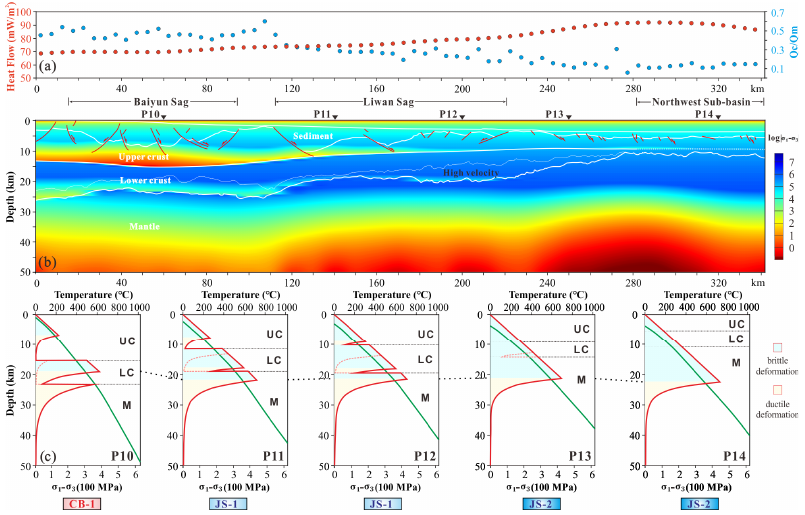
Figure 9. ( a ) The values of Q c /Q m and surface heat flow are represented by the blue points and red points, respectively. ( b ) The constructed lithospheric rheological structure of profile L3. ( c ) The thermo ‐ rheological models estimated at the typical locations of P10–P14. Green lines denote the geothermal curve. Red dotted lines and red solid lines indicate the yield stress envelope (YSE) of intermediate granulite and mafic granulite taken in lower crust model, respectively. The classical rheological models of JS − 1, JS − 2, and CB − 1 were recognized along profile L1 by the light blue, dark blue, and pink rectangles, respectively. JS − 1, jelly sandwich regime with weak lower crust; JS − 2, jelly sandwich regime with relatively strong lower crust; CB ‐ 1, crème brûlée regime with weak lower crust. Q c , crustal heat flow; Q m , mantle heat flow; UC, upper crust; LC, lower crust; M, upper mantle. An entirely different pattern of lateral changing trend in rheological structures is pre ‐ sented along profile L3 (Figure 9). Considering the widespread lower crustal HVLs, the lower crust of the eastern PRMB is usually taken to be closer to the rheology of mafic granulite, which exhibits a higher strength [63] (Table 2). As a comparative study, the re ‐